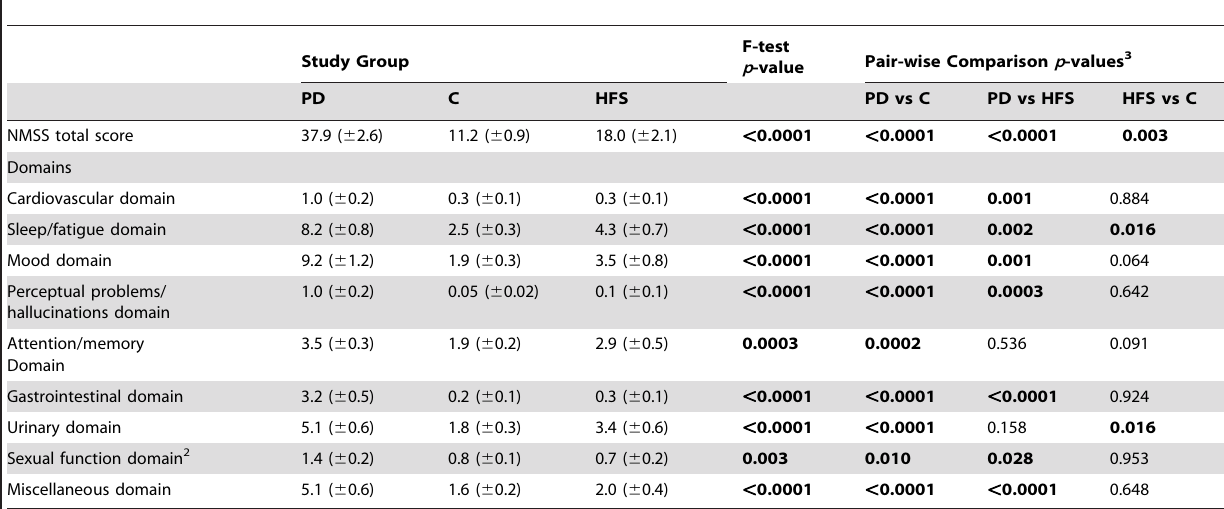
Table 2. Comparisons of estimated NMSS total and domain scores 1 by study